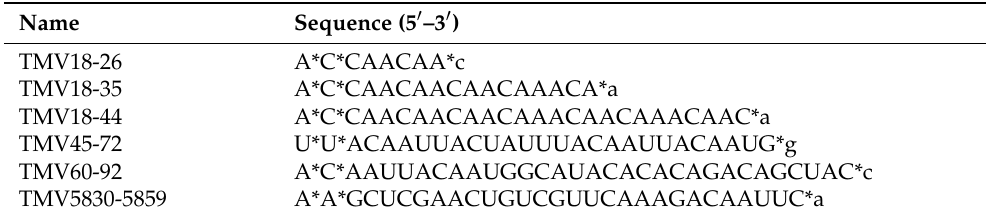
Table 1. Small RNA fragments used in this